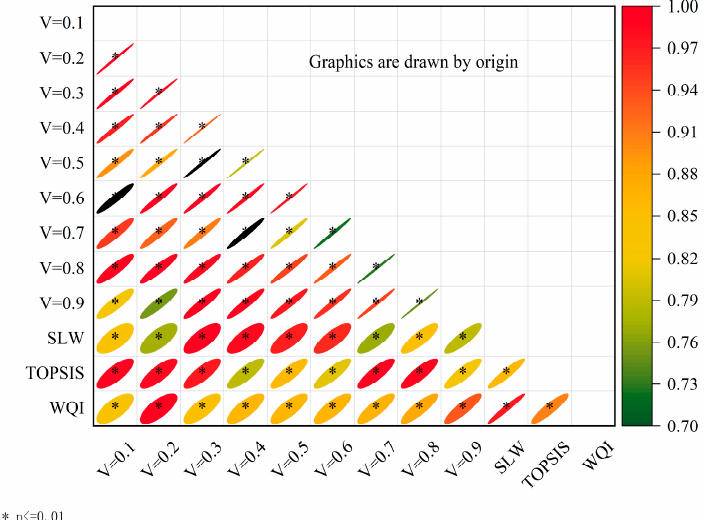
Figure 11. Sensitivity analysis of evaluation in the Maotiao River Basin (Gizhou province, SW China) in 2020.